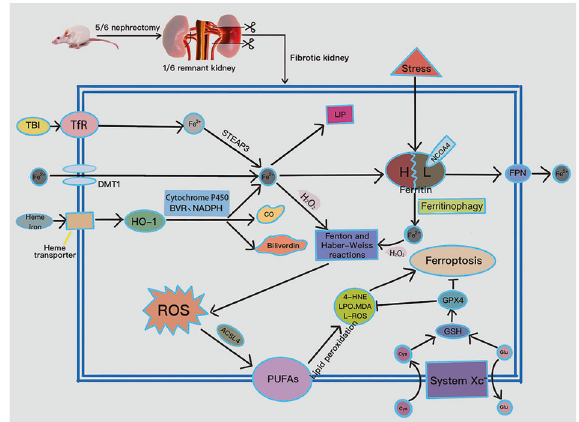
Fig. 7 Disordered iron metabolism and ferroptosis occurred in 5/6 nephrectomy-induced CKD rats. DMT1 and TfR expression were down-regulated, while HO-1 was up-regulated; the latter catabolizes heme iron to ferrous iron, CO, and biliverdin, with the assistance of cytochrome P450, biliverdin reductase (BVR), and NADPH. TfR mediates the import of transferrin-bound iron (TBI) into the cell and reduces ferric iron to ferrous iron via six-transmembrane epithelial antigen of prostate 3 (STEAP3). Regarding iron export, FPN down-regulation blocks iron ef fl ux, leading to elevated intracellular iron concentration. A small amount of intracellular ferrous iron is stored in the labile iron pool (LIP) to maintain physiological metabolism, while the remainder is endogenously chelated by ferritin. Excess intracellular catalytic iron reacts with hydrogen peroxide to initiate the Fenton and Haber-Weiss reactions, leading to a further increase in ROS and attacks on polyunsaturated fatty acids (PUFAs) in the cytomembrane, initiating lipid peroxida- tion and ferroptosis. In addition, down-regulation of SLC7A11 results in reduced synthesis of GSH from Cys, decreased GPX4 activity, and weakened anti-ferroptotic responses. CO carbon monoxide, Glu glutamate.